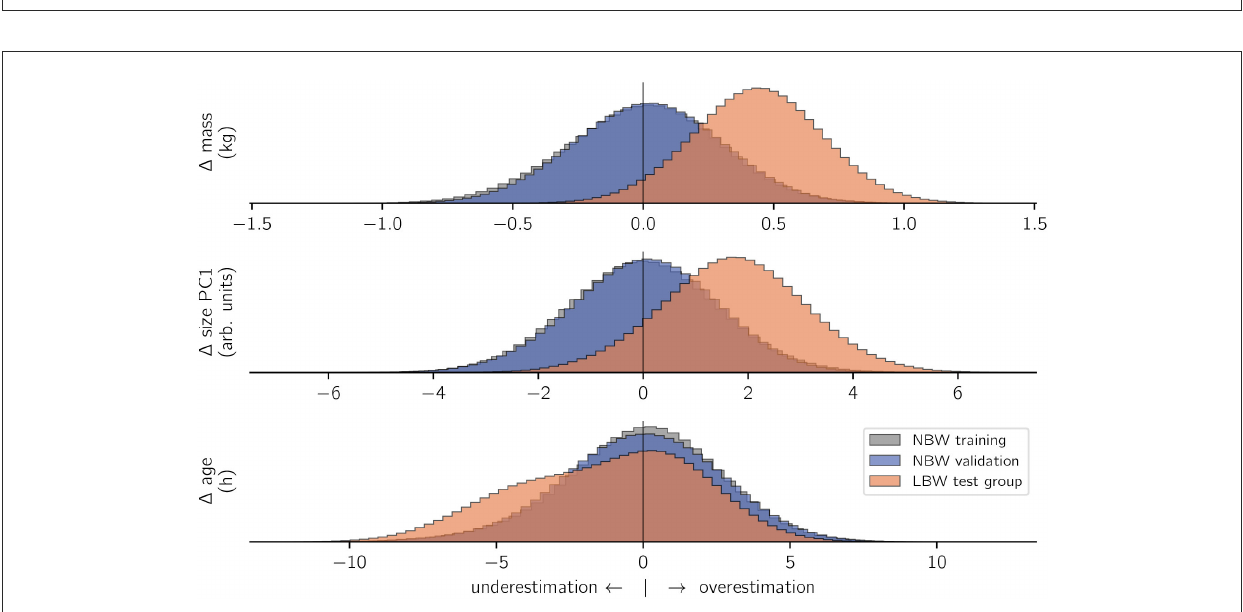
FIGURE4 Model inference. For all included subject characteristics, models which were trained on NBW strides correctly inferred the training data (gray) and values from the validation set (blue). In contrast, the same models wrongly inferred the characteristics of LBW subjects (orange). The x -axes show the difference ( 1 ) between actual and predicted values per prediction. To facilitate comparison, histogram heights are again normalized per